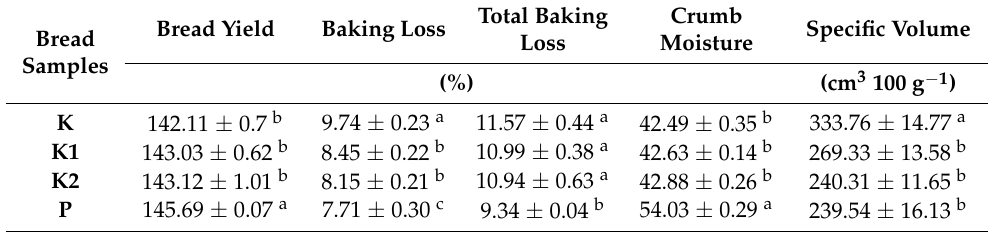
Table 3. Quality characteristics of bread with S. cerevisiae supplemented with magnesium ions. Control samples of the bread with yeast: K, dry yeast; K1, without magnesium and PEF treatment; K2, with magnesium and without PEF treatment; P, with magnesium and PEF treatment. Total Baking Crumb Bread Yield Baking Loss Bread Loss Samples